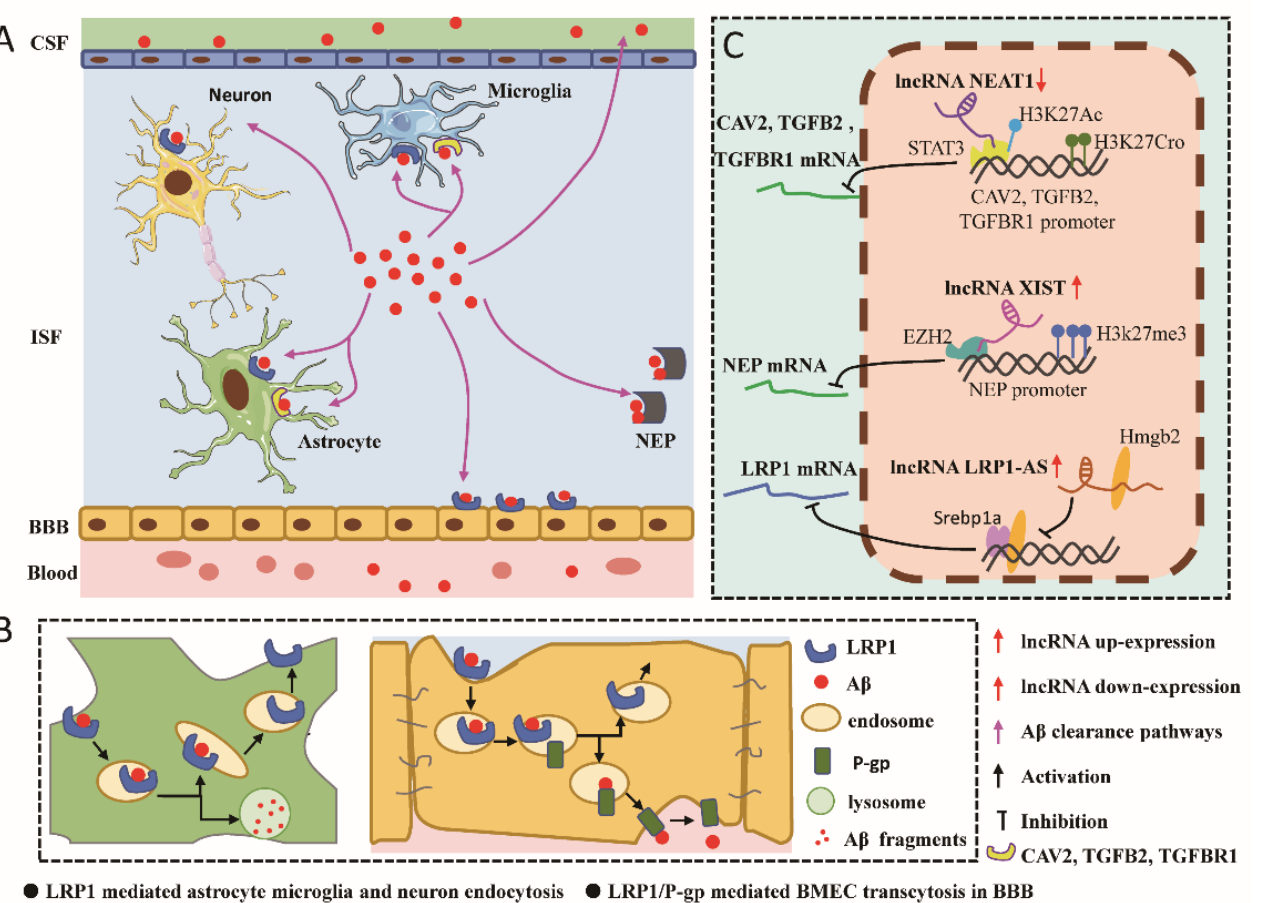
Figure 2. Mechanisms of lncRNA in Aβ clearance pathway. ( A ) Overview of Aβ clearance pathway. ( B ) Schematic representation of LRP1-mediated endocytosis in microglia, astrocytes, and neurons. Schematic representation of LRP1/P-gp-mediated transmigration of brain microvascular endothelial